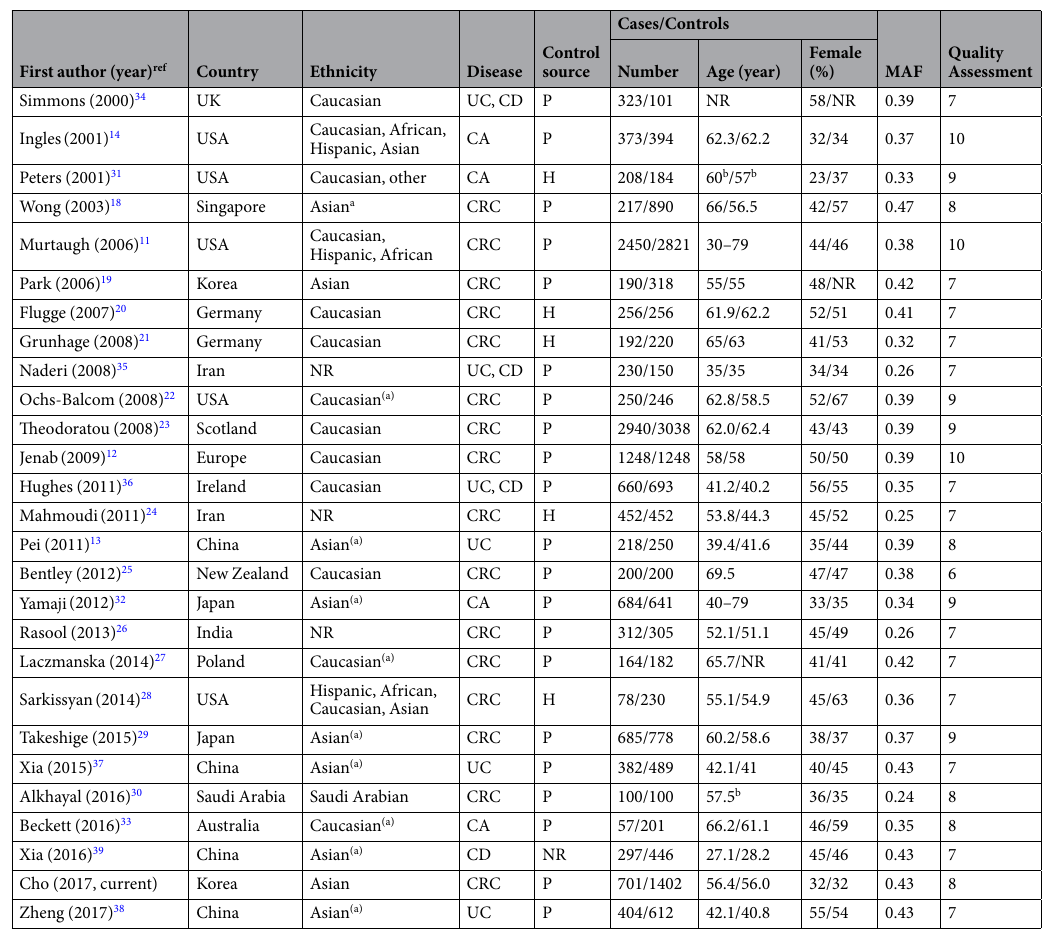
Table 2. Characteristics of the studies included in the meta-analysis. (a) No information on race in the paper. The race was hypothesized based on the more frequent ethnicity in the study country; (b) Median. Abbreviations: CA, colorectal adenoma; CD, Crohn’s disease; CRC, colorectal cancer; H, hospital-based; MAF, minor allele frequency (f allele); NR, not reported; P, population-based; UC, ulcerative